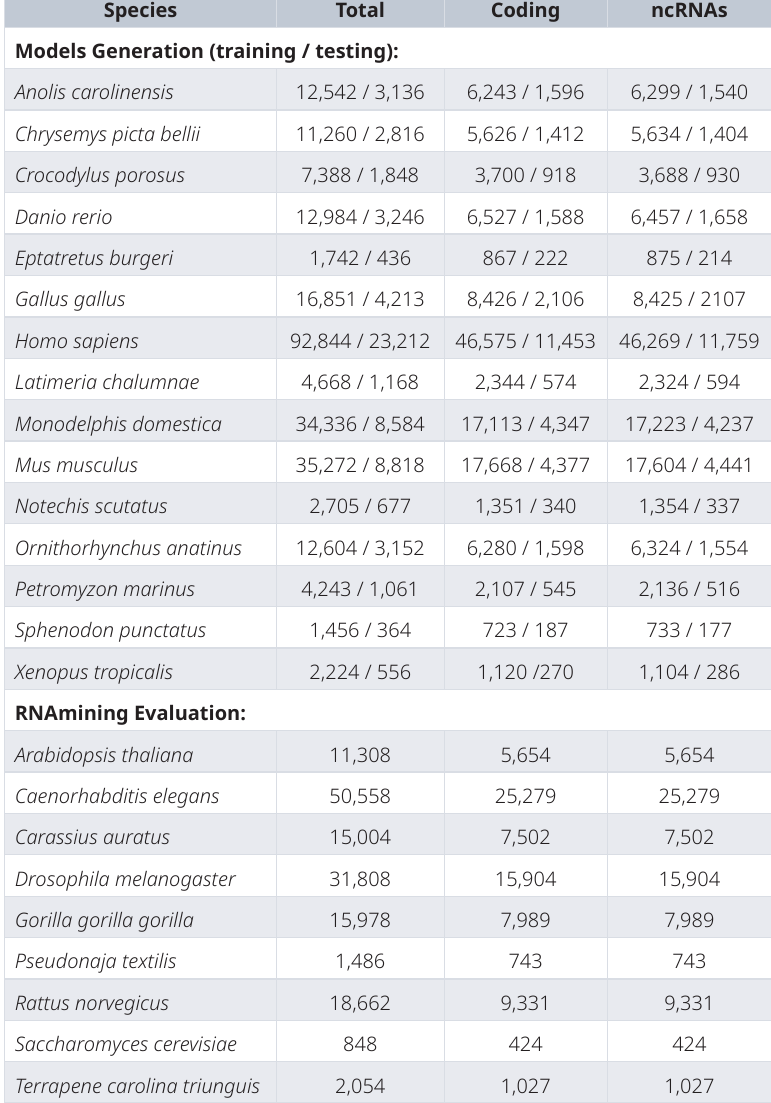
Table 1. Set of sequences used in the training and testing datasets. List of organisms and the total number of sequences used for testing and training both coding and non-coding RNAs. The numbers are separated into training/testing values. All sequences can be retrieved at RNAmining website (https://rnamining. integrativebioinformatics.me/download